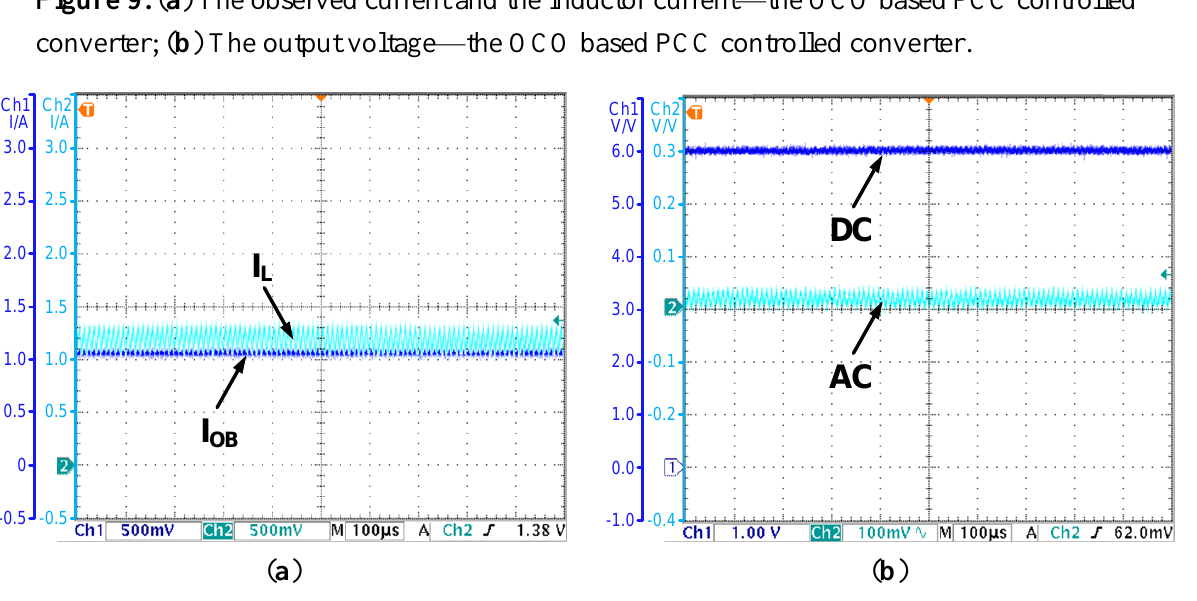
Figure 9. ( a ) The observed current and the inductor current—the OCO based PCC